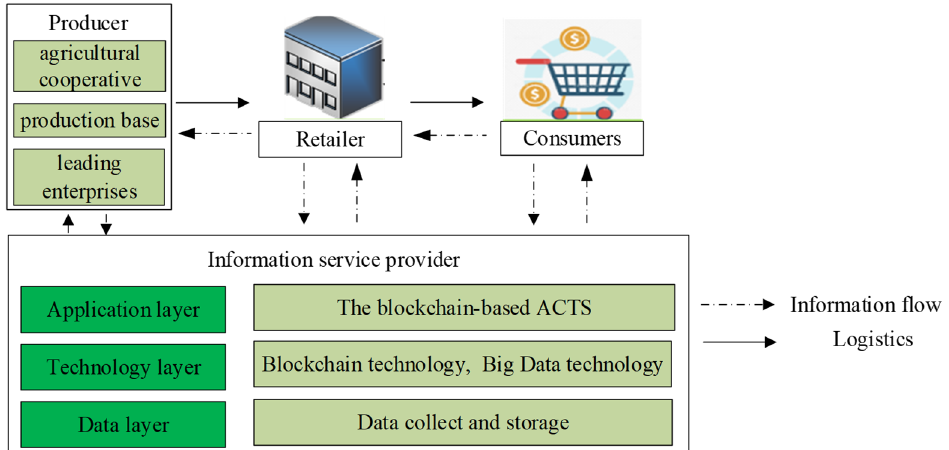
Figure 2. The supply chain structure after adopting a blockchain-based